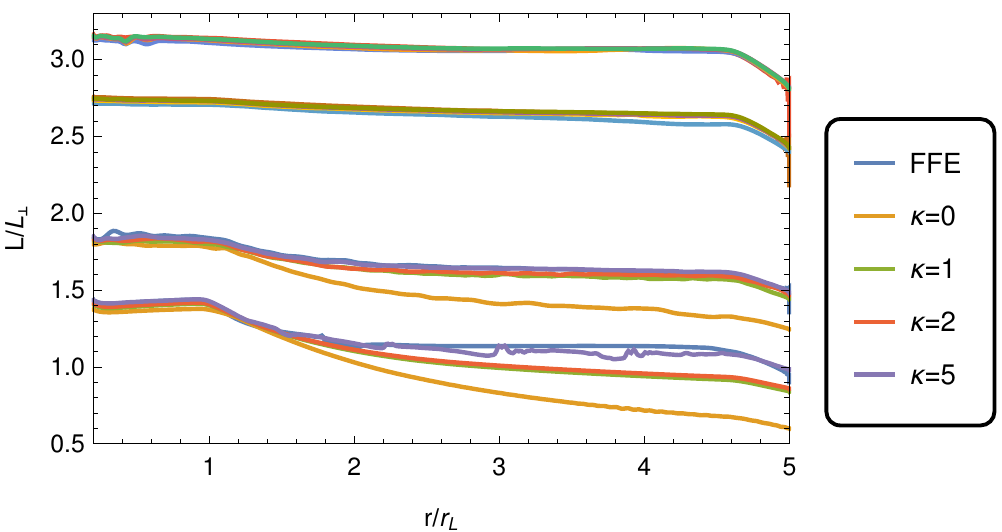
Figure 2. The radial dependence of the Poynting flux for an oblique rotator in force-free and radiative